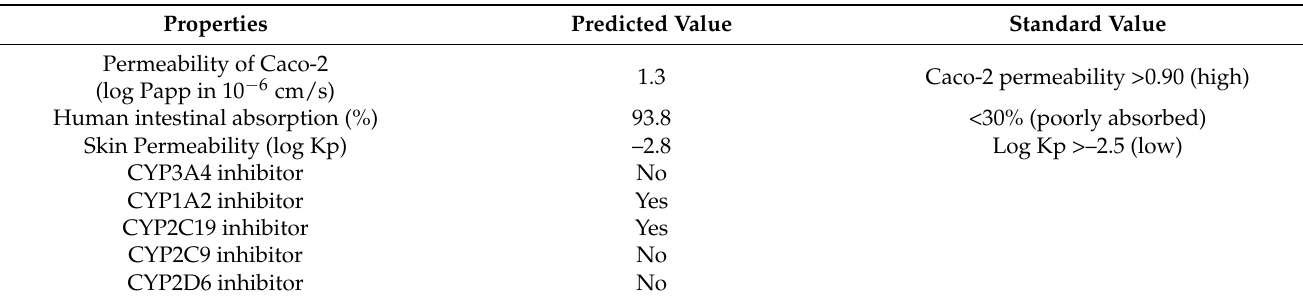
Table 2. Pharmacokinetic properties of